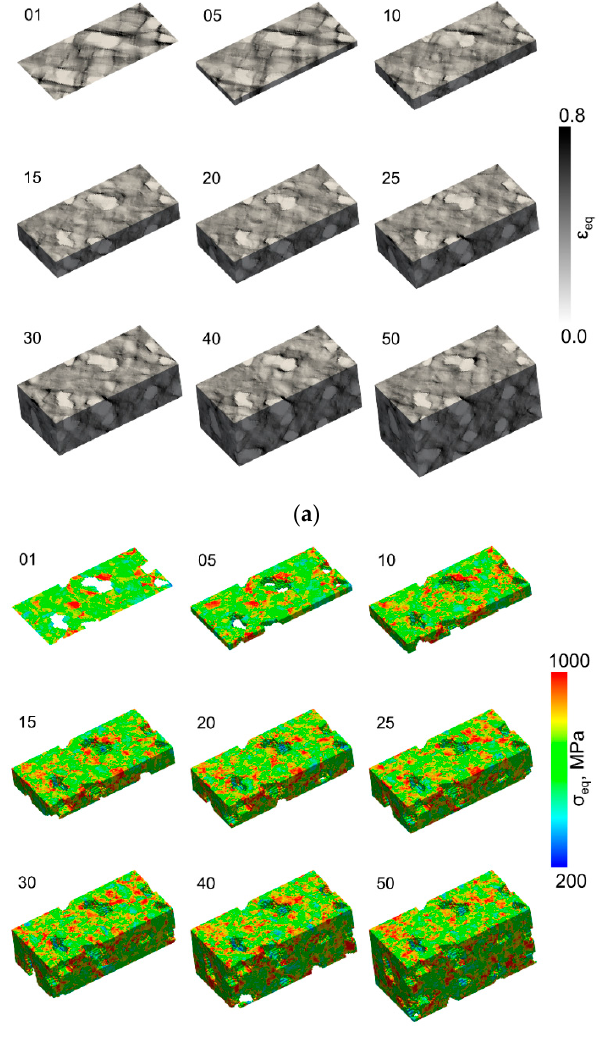
Figure 13. Local distribution for all geometries of RVE-E at 25% of the true global strain: ( a ) von Mises true strain distribution; and ( b ) von Mises true stress distribution. It is observed that in 1 layer, there is a high contrast of stresses and strains, but with increasing layer thickness, the distribution is more homogeneous RVEs (reprinted with permission from [45], MDPI, 2020). Appl. Sci. 2021 , 11 , x FOR PEER REVIEW